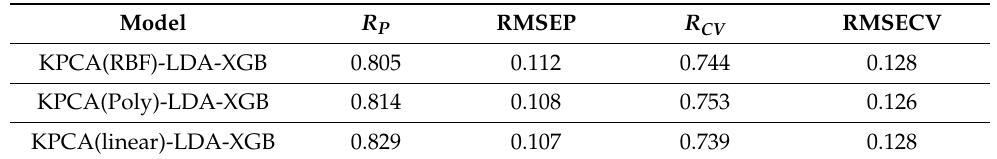
Table 4. Comparison of the prediction and cross validation performance of the linear kernel function with the other kernel functions in the KPCA-LDA-XGB